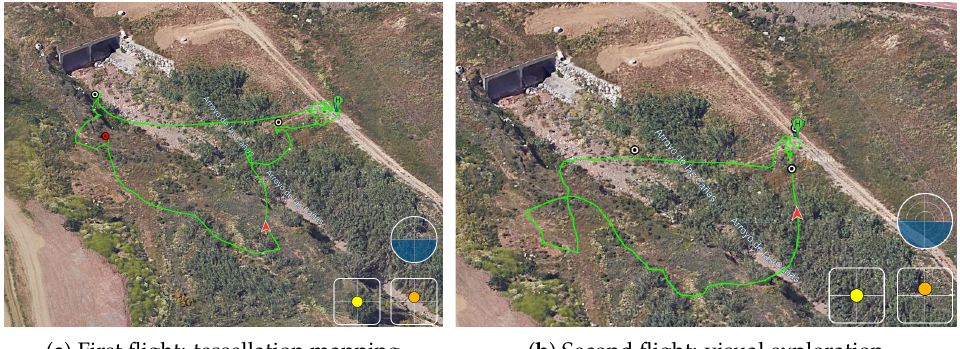
Figure 10. Panoramic aerial views (DJI Flight Log